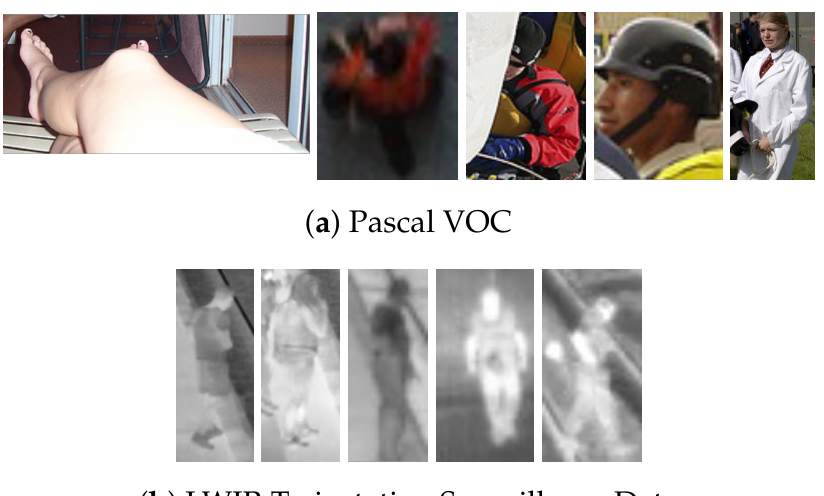
Figure 1. Example images from both datasets.